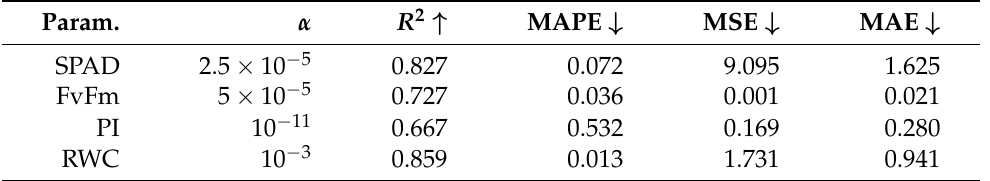
Table 6. The Ridge regression model with the L2 regularization.